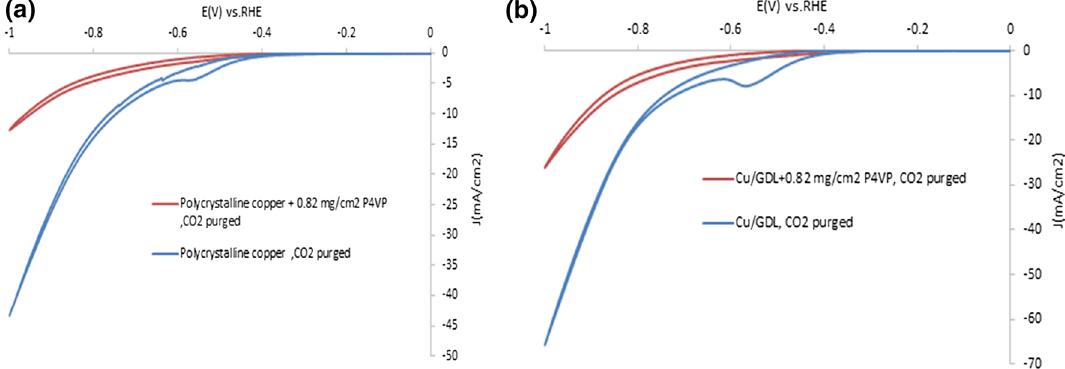
Fig. 4 CV curve of polycrystalline copper and Cu/GDL before and after P4VP loading in CO 2 -purged 1 M KHCO 3 electrolyte at pH 6.7. a Polycrystalline copper, blank electrolyte. b Cu/GDL, blank electrolyte. Scan rate: 50